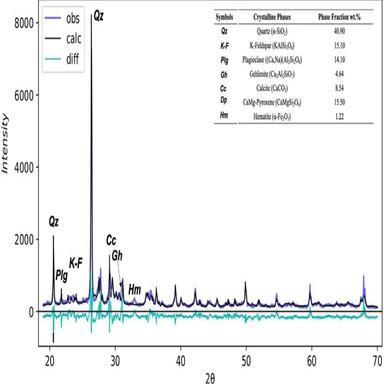
Rietveld plot of the ancient ceramic. Diffraction peaks of the main phases are labelled. The difference ("diff") between the observed ("obs") and calculated ("calc") profile is not in scale.